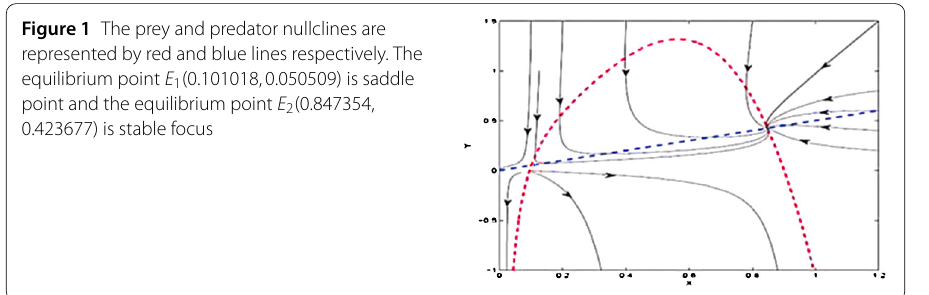
Figure 1 The prey and predator nullclines are represented by red and blue lines respectively. The equilibrium point E 1 (0.101018,0.050509) is saddle point and the equilibrium point E 2